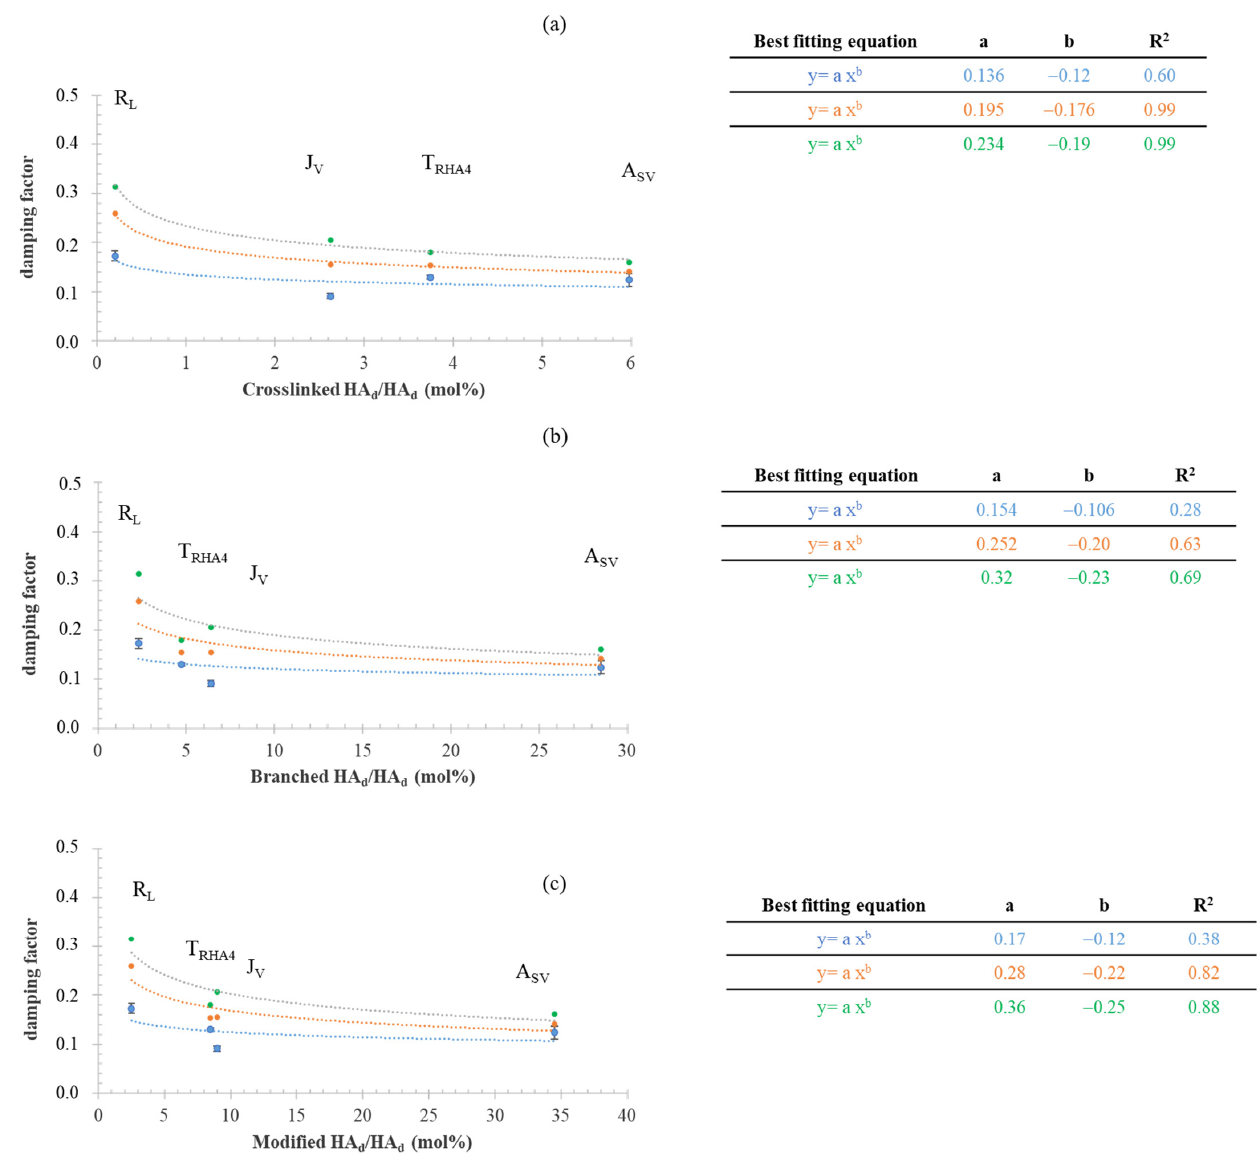
Figure 6. Correlation of the damping factor with the HA chemical modification parameters of the gels while hydrating. Tan delta as a function of crosslinked HA d (%) ( a ), branched HA d (%) ( b ), and modified HA d (mol%) ( c ) with increasing hydration in the physiological medium. Specifically, the curves for the damping factor values measured for the gels in the syringe (blue) and after twofold (orange) and threefold (green) hydration in the physiological medium are shown. The equation for the best-fitting curve and related parameters are also shown for each set of experimental data. A power law regression was used to fit the data showing the highest values for the determination coefficient. The latter improved with hydration, and, for the hydrated gels, the damping factor was strongly correlated with the amount (mol%) of crosslinked HA d (R 2 0.99). Even for tan δ , the correlation with the amount of branched HA d and with the total HA modification degree was worse. Unlike G ′ , the damping factor varied over a wider range after hydration (0.12–0.17 for the gels as commercialized and 0.16–0.31 for the hydrated gels).